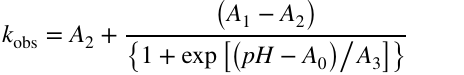
Fig. 1 Effect of Cr(VI) reduc- tion by sugarcane molasses on different pH values (2.0–8.0)